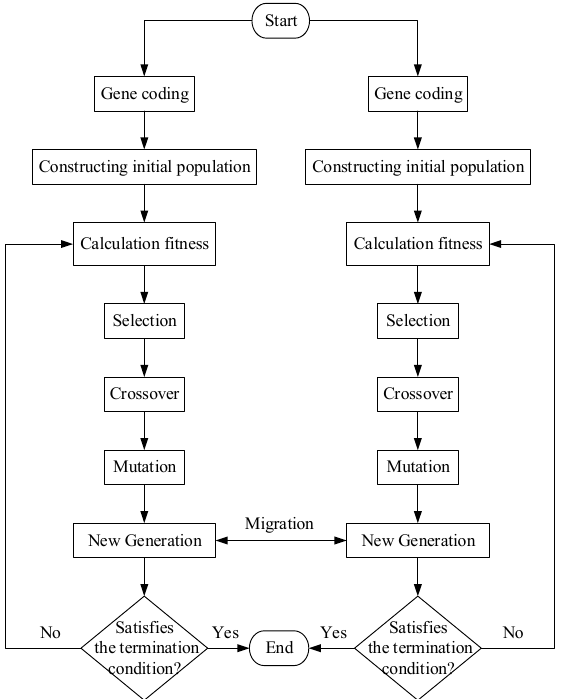
Figure 3. Flow chart of two-populations-with-enhanced-initial-population based on genetic algorithm (TI_GA) .